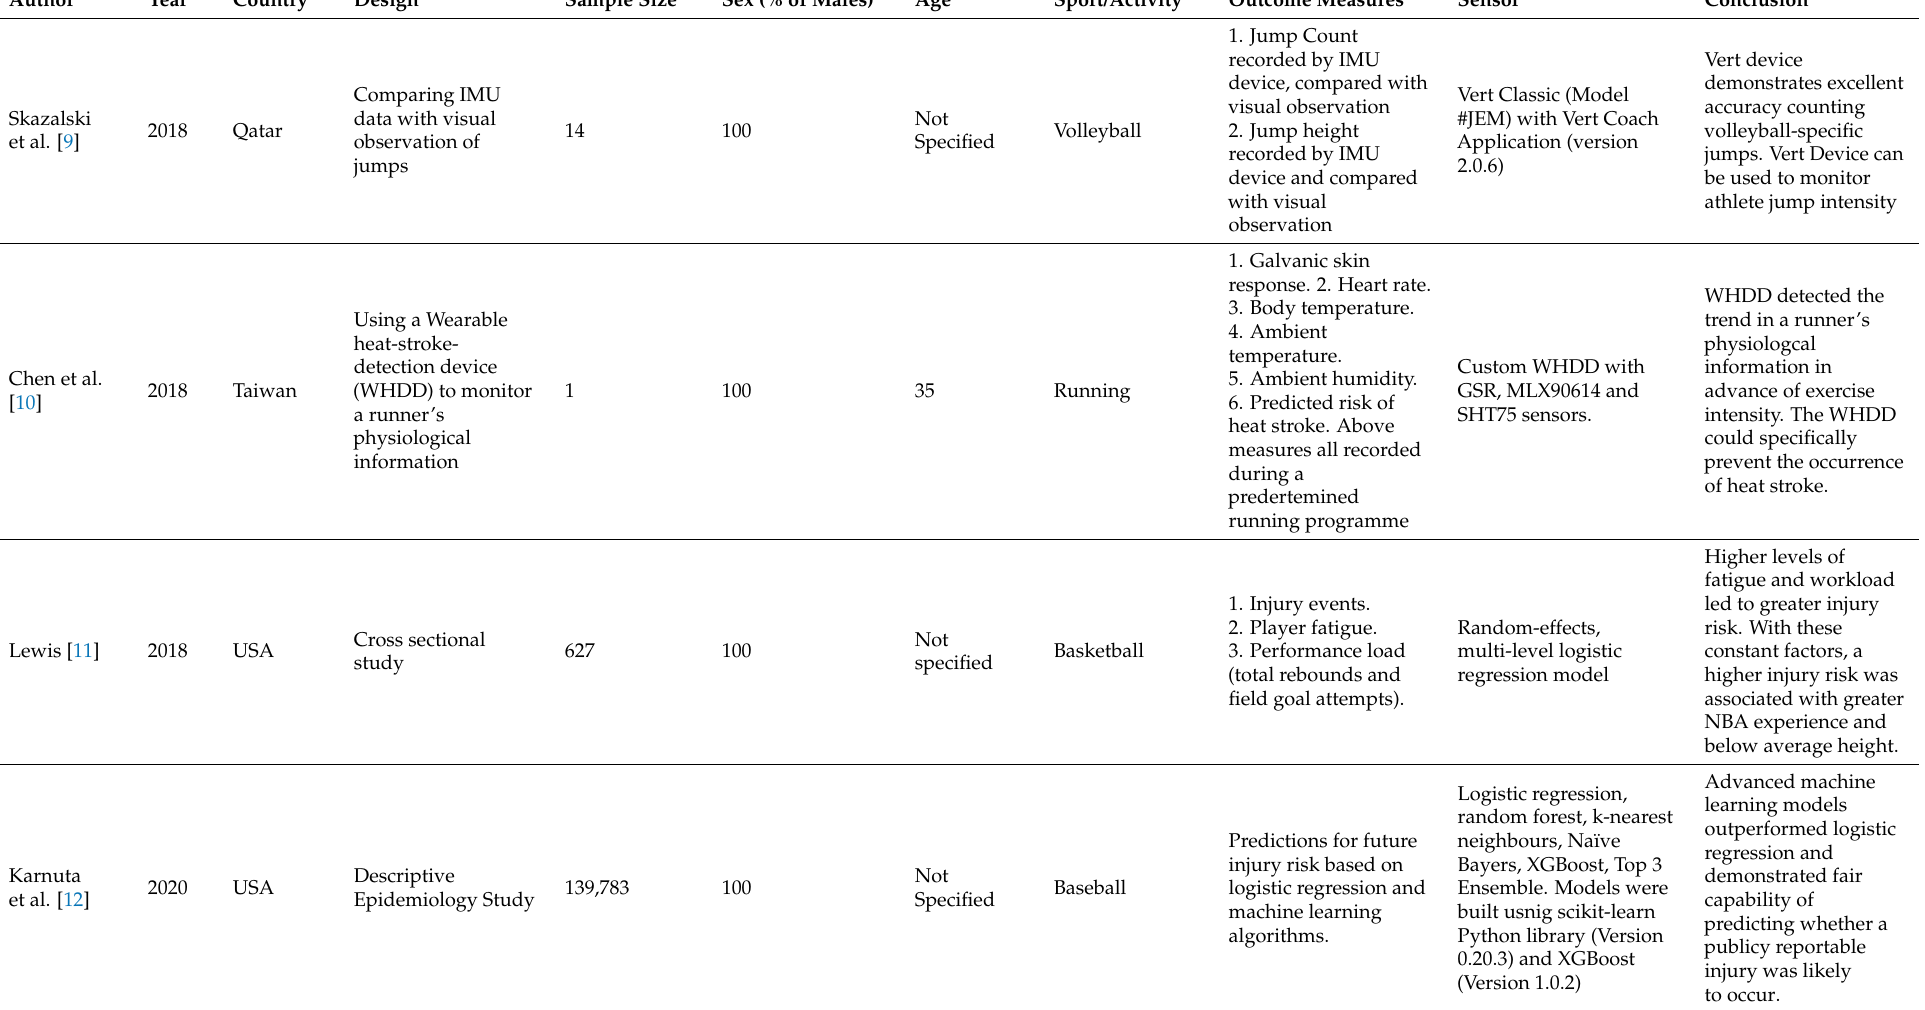
Table 1. Studies reporting sensors’ use in the different phases of sports and the outcome